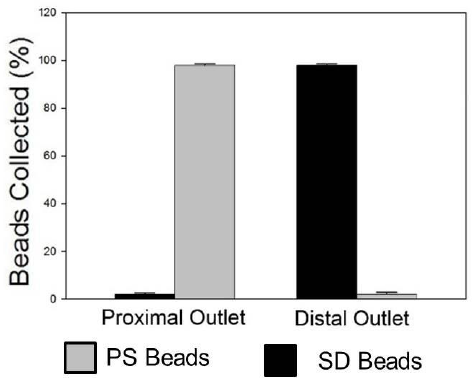
Figure 4. Quantitative assessment of beads collected via the proximal and distal outlets using a hemocytometer under bright-field imaging and fluorescence microscopy. Results show that >99% of PS beads were obtained via the proximal outlet, whereas >99% of SD beads were obtained via the distal outlet ( n = 5).